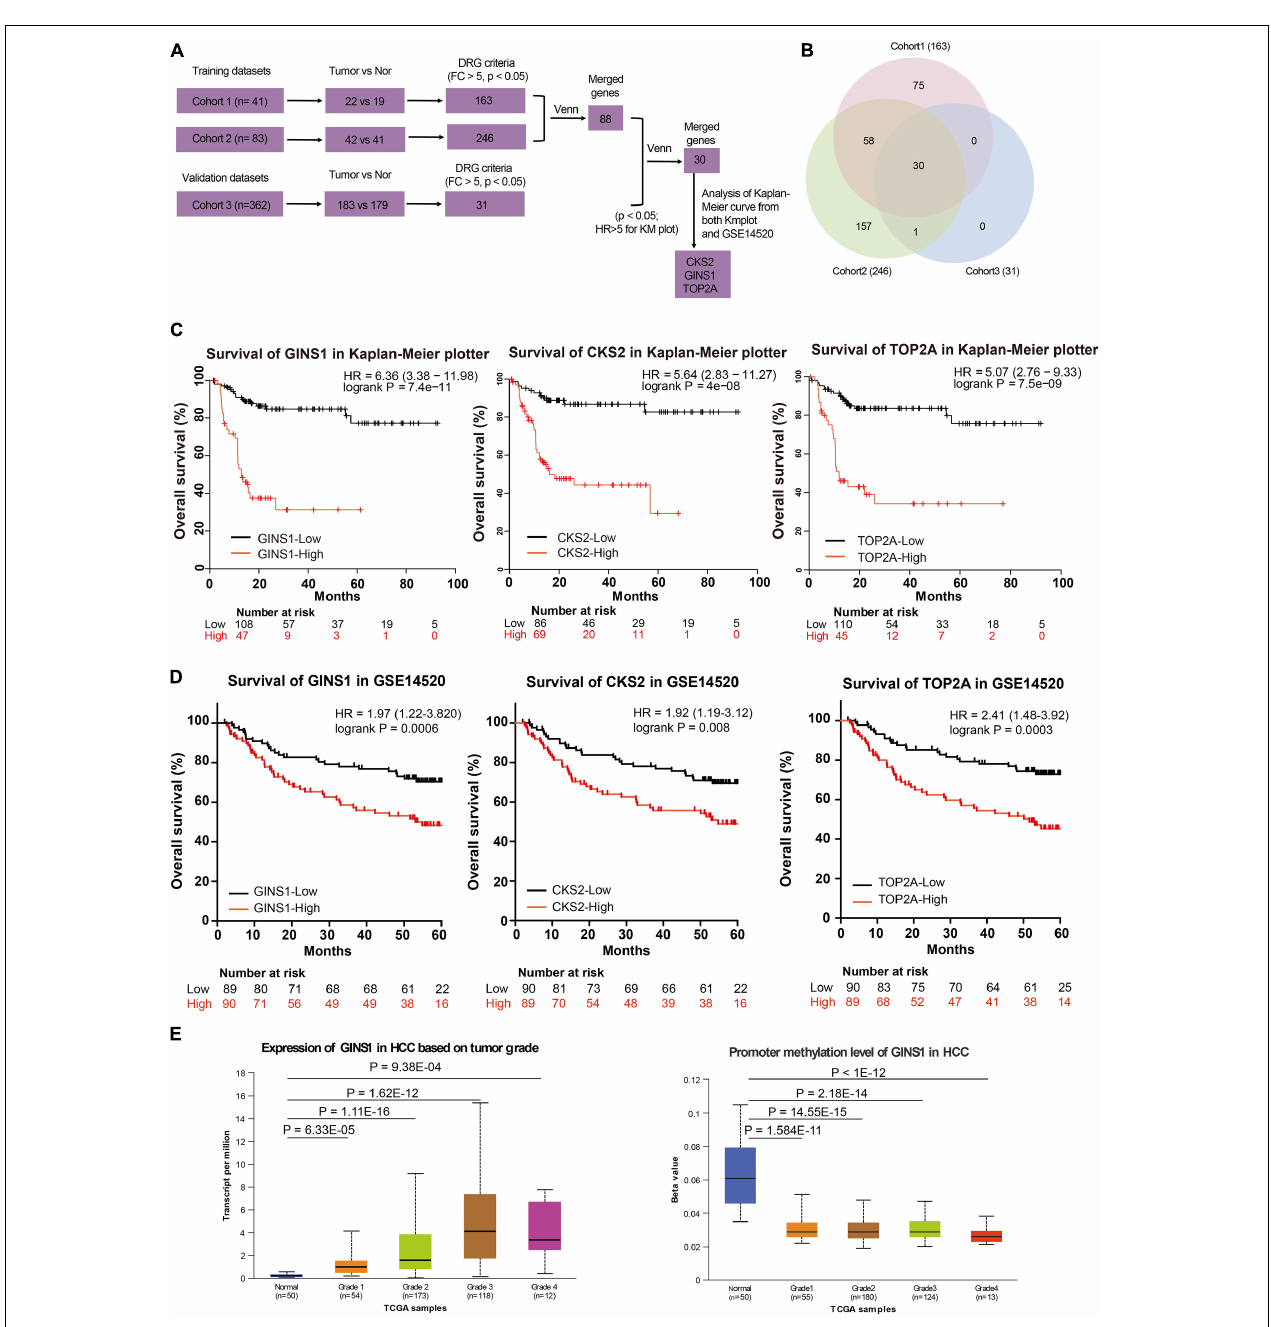
FIGURE 1 | Transcriptome and survival analysis in the two independent databases. (A,B) gene expression profiles and venn diagram in GSE14520. (C,D) Survival analysis present within Kaplan–Meier plotter online tool (C) and the GSE14520 data (D) . (E) transcriptional (left panel) and promoter methylation (right panel) levels of GINS1 in HCC based on tumor grade present within TCGA data. Data are presented as mean ±